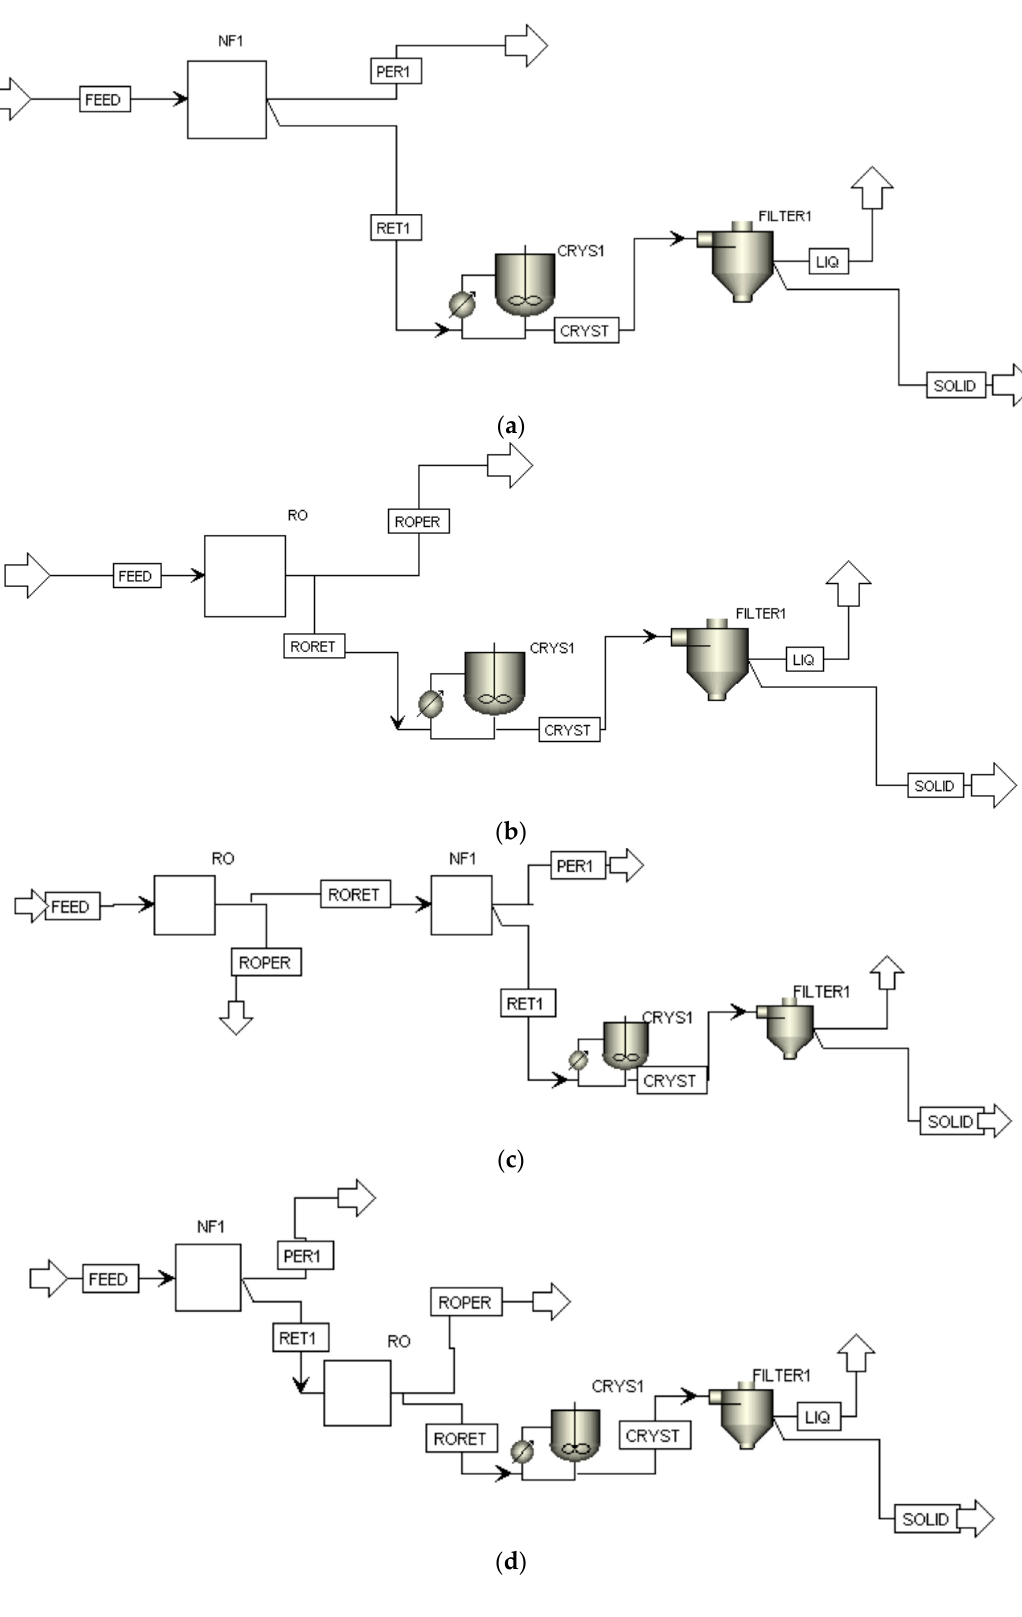
Figure 3. Aspen Plus flowsheet of the processes ( a ) nanofiltration-crystallization (NF-Cryst); ( b ) reverse osmosis (RO)-Cryst; ( c ) RO-NF-Cryst; ( d ) NF-RO-Cryst.